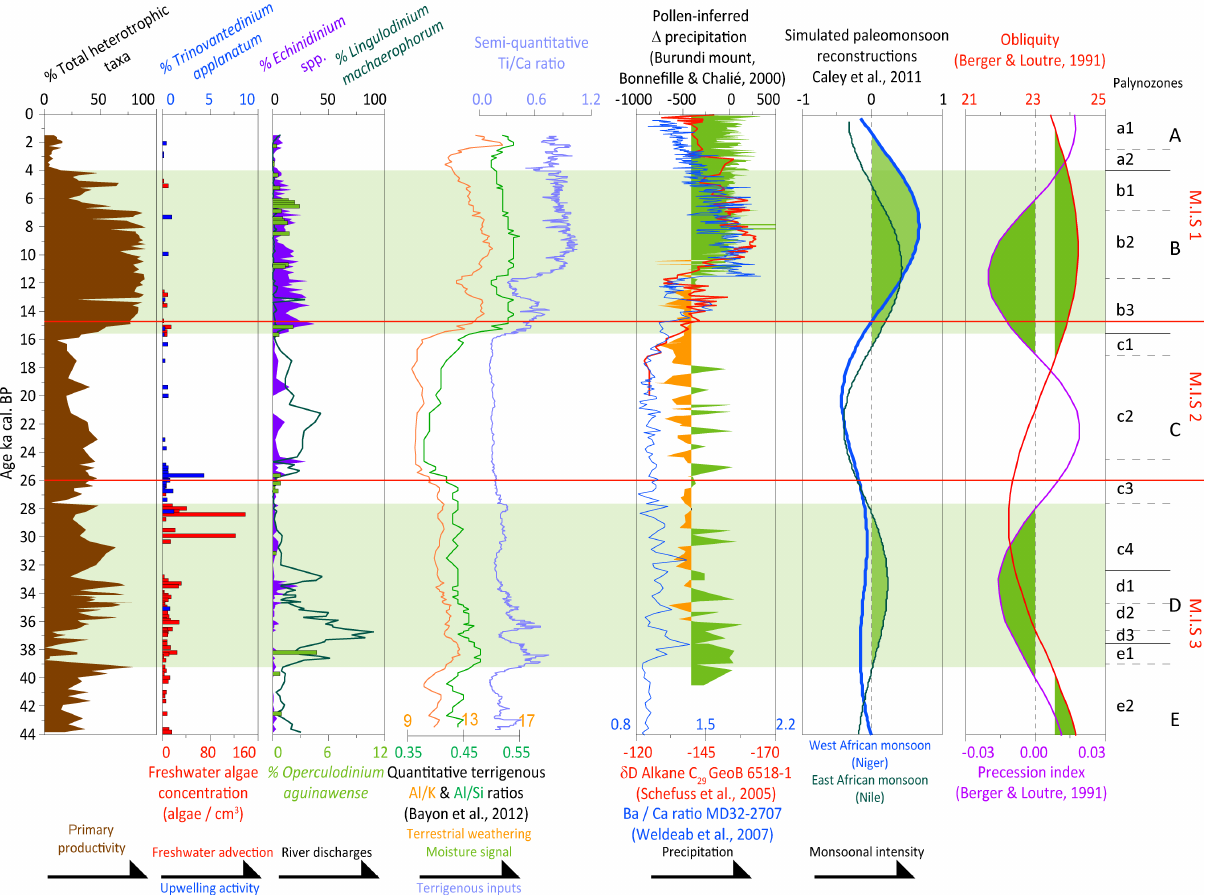
Figure 7. Comparison between total heterotrophic cyst abundances and Trinovantedinium applanatum percentages, both accounting for up- welling activity (Marret and Zonneveld, 2003). River-plume taxa: Echinidinium spp. and Lingulodinium machaerophorum as well as coenobia of freshwater microalgae Pediastrum and terrigenous signals (XRF Ti / Ca ratio, quantitative measurements of major elements Al / K and Al / Si; Bayon et al., 2012). This allows discussing Congo River discharges. Relationships between river discharges and palaeomonsoons are displayed through (i) pollen-inferred rainfall anomalies in Burundi mountains (Bonnefille and Chalié, 2000: the threshold with posi- tive anomalies in green and negative anomalies in orange is calculated from mean glacial values) in parallel with δD on alkane C 29 (core GeoB6518; Schefuß) displayed in red, (ii) regional-scale monsoon reconstructions (western and eastern African monsoons; Caley et al., 2011: maximal monsoon regimes are underlined in green), and (iii) Globigerinoides ruber Ba / Ca ratio obtained from core MD32-2707 (Weldeab et al., 2007). Orbital parameters such as the obliquity and the precession (Berger and Loutre, 1991) are also displayed, with pre- cession minima and obliquity maxima highlighted in green. Green bands correspond to major orbital-scale moisture conditions discussed in the